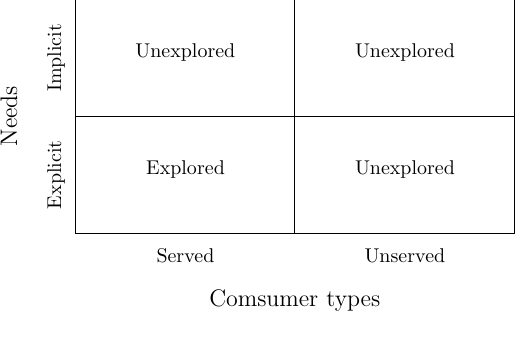
Figure 2: Red and blue